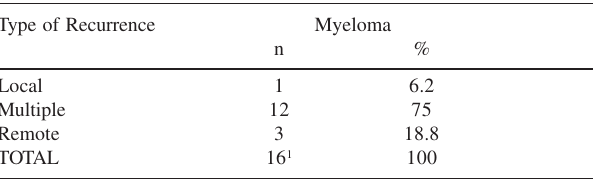
Table 1 - Type of recurrence of primary tumors in patients with plasmacytoma that progressed to myeloma (absolute and relative (%) frequency distribution)